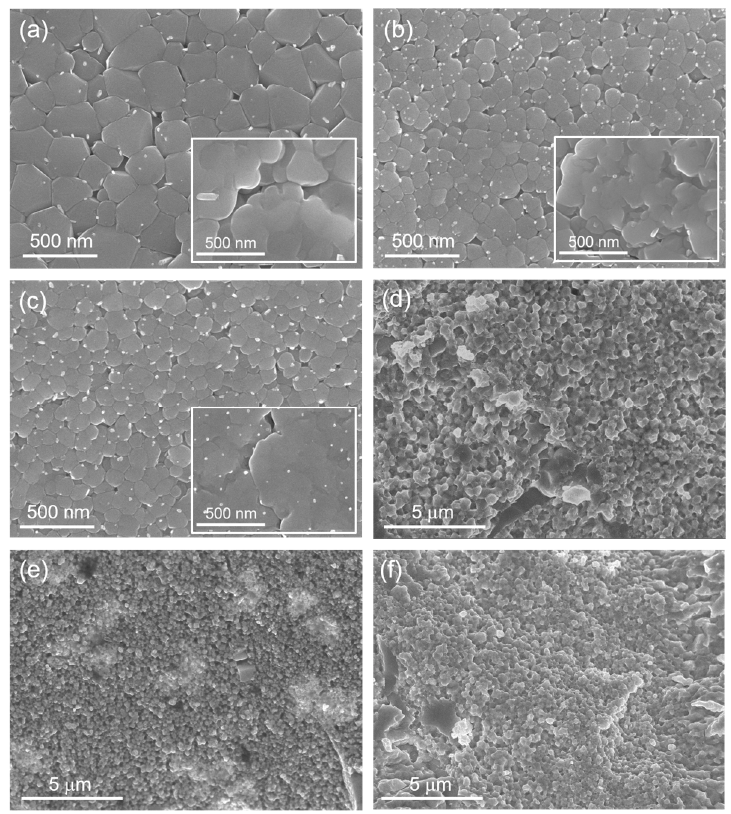
Figure 1. SEM (scanning electron microscopy) images for contact surfaces of melt-spun ribbons of ( a ) (Hf 0.5 Zr 0.5 )NiSn 0.98 Sb 0.02 , ( b ) (Hf 0.5 Zr 0.5 ) 0.8 Ti 0.2 NiSn 0.98 Sb 0.02 , and ( c ) (Hf 0.5 Zr 0.5 ) 0.7 Ti 0.3 NiSn 0.98 Sb 0.02 . Insets in ( a – c ) show the SEM images for free surfaces. SEM images for the fractured surfaces of SPS (spark plasma sintering) sintered bulks of ( d ) (Hf 0.5 Zr 0.5 )NiSn 0.98 Sb 0.02 , ( e ) (Hf 0.5 Zr 0.5 ) 0.8 Ti 0.2 NiSn 0.98 Sb 0.02 , and ( f ) (Hf 0.5 Zr 0.5 ) 0.7 Ti 0.3 NiSn 0.98 Sb 0.02 .